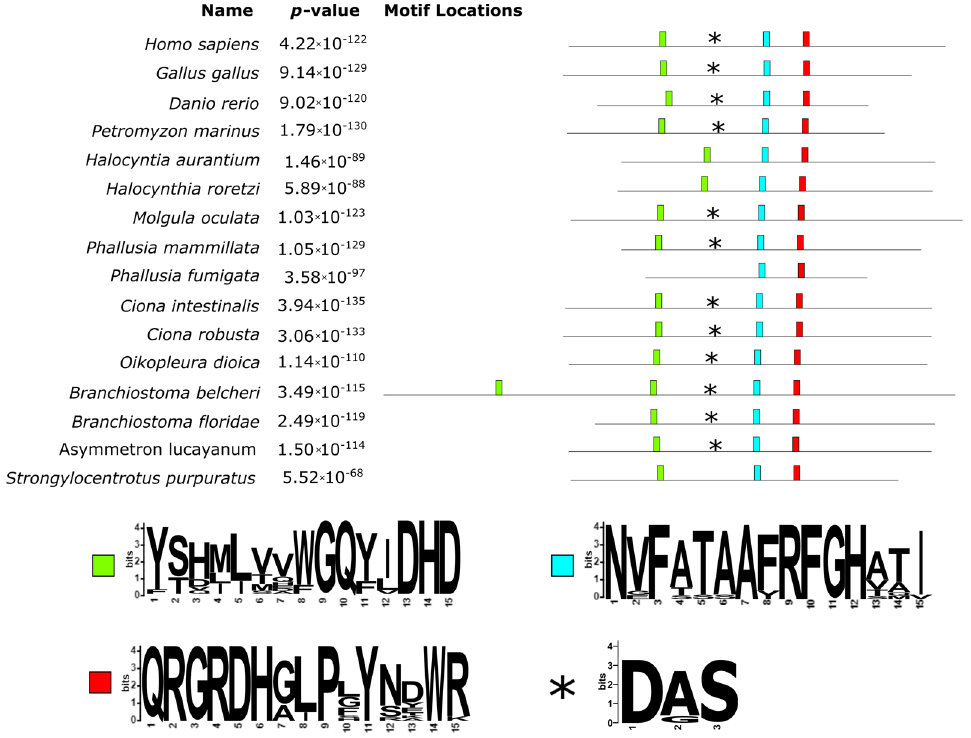
Figure 3. Conserved domain locations and SeqLogo as inferred by the MEME suite on the TPO protein sequences. The proteins were aligned to highlight the occurrence and positioning of the homologous conserved domains; the positions of the boxes reflect the actual positions in the alignment (see Supplementary Materials Figure S1). Distal and proximal histidine conserved domains are shown in the green and light blue boxes, respectively, while the asterisks denote the region of the Ca-binding site. Slightly downstream, the third conserved sequence containing the Asn residue can be found (red box).